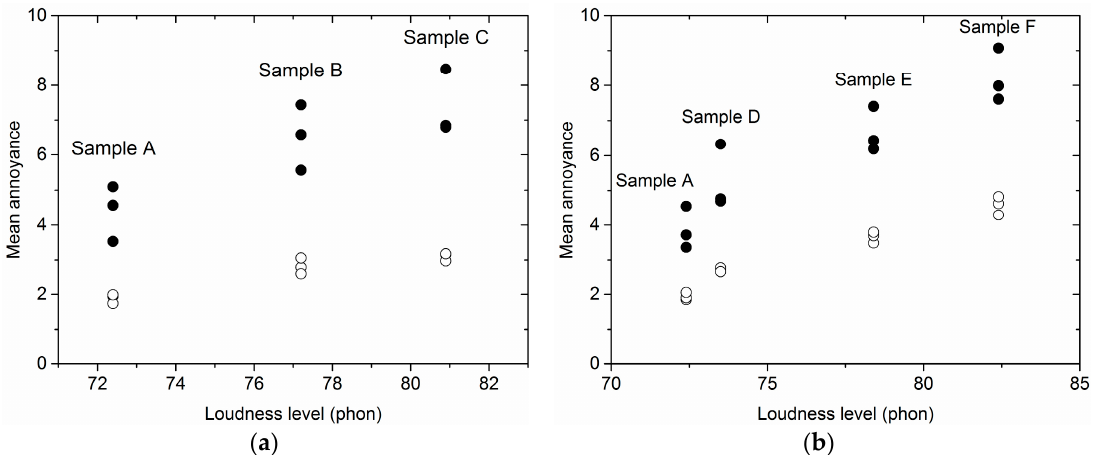
Table 5. The standard deviation and coefficient of variation of MA for samples A, D, E and F obtained from sample sets 4–6 before and after calibration. Figure 3. The differences of MA of identical samples (samples A–E) from different sample sets before and after calibration. ( a ) MA of samples A–C obtained from sample sets 1–3; ( b ) MA of samples A, D, E and F obtained from sample set 4–6 ( ● : before calibration; ○ : after calibration). Table 4. The standard deviation and coefficient of variation of MA for samples A–C obtained from sample sets 1–3 before and after calibration.